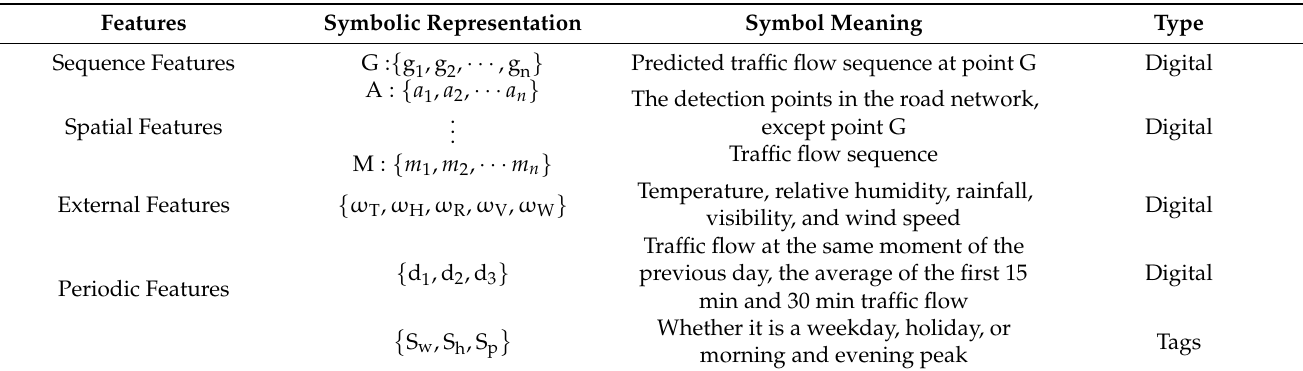
Table 2. Set of traffic flow